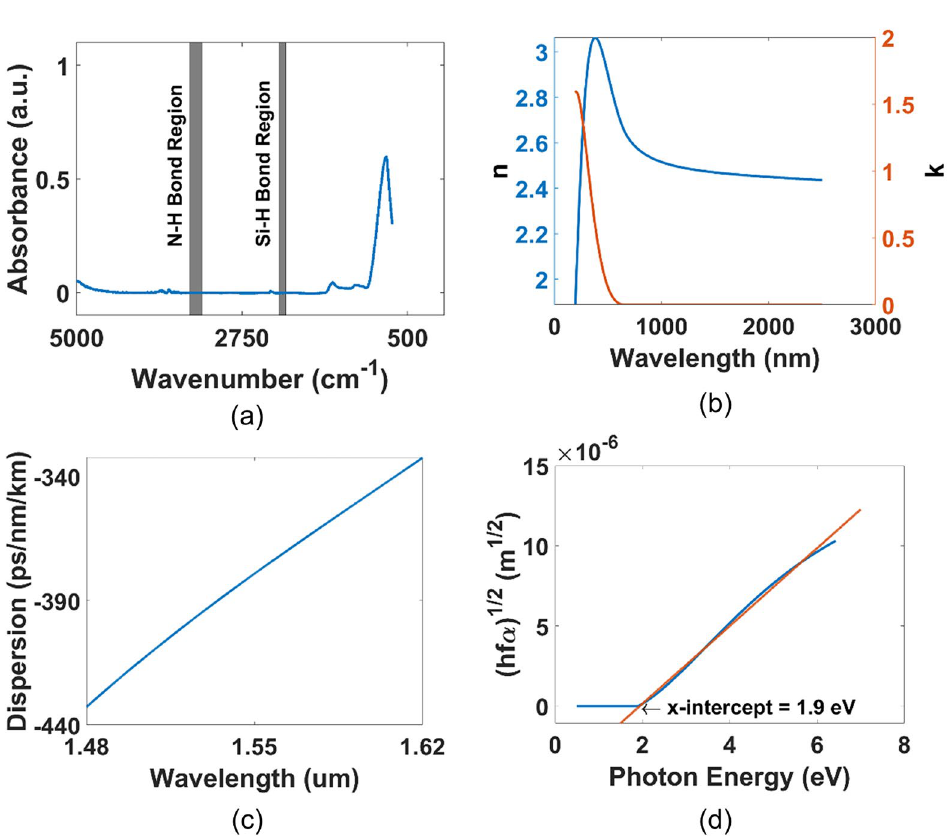
Figure 1. ( a ) Baseline-adjusted absorbance plot exhibiting regions where Si–H and N–H bonds could occur. We note no peak occurrences in these regions, indicating absence or negligible Si–H and N–H bonds. ( b ) Refractive index n ( — ) and extinction coefficient k ( — ) data extracted using FTIR measurements ( c ) Material dispersion curves from 1.48 to 1.62 µm for the SRN-D film ( d ) Tauc’s plot of the SRN-D film with the original curve ( — ) and fitted line ( —